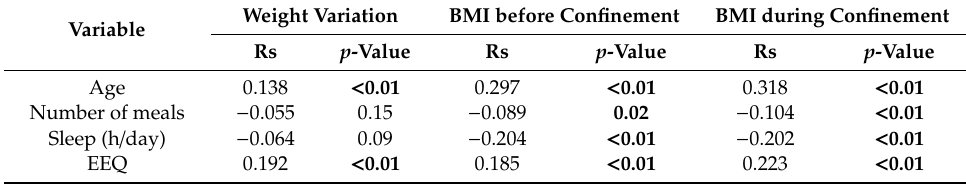
Table 3. Correlation analysis of anthropometric values with general characteristics and lifestyle.